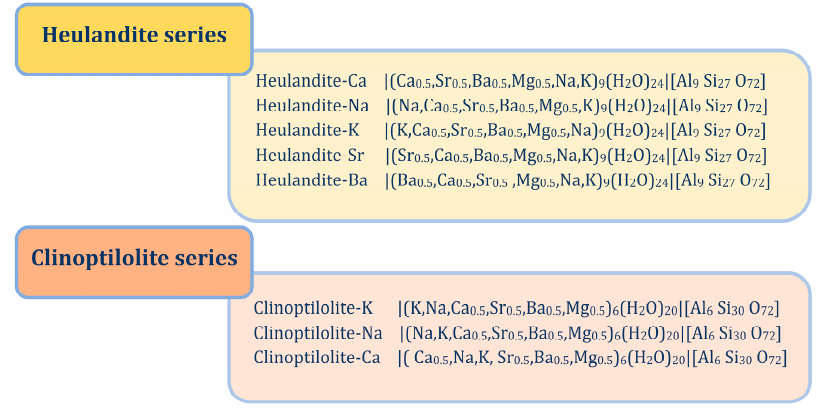
Figure 4. Idealized compositions of heulandite and clinoptilolite series